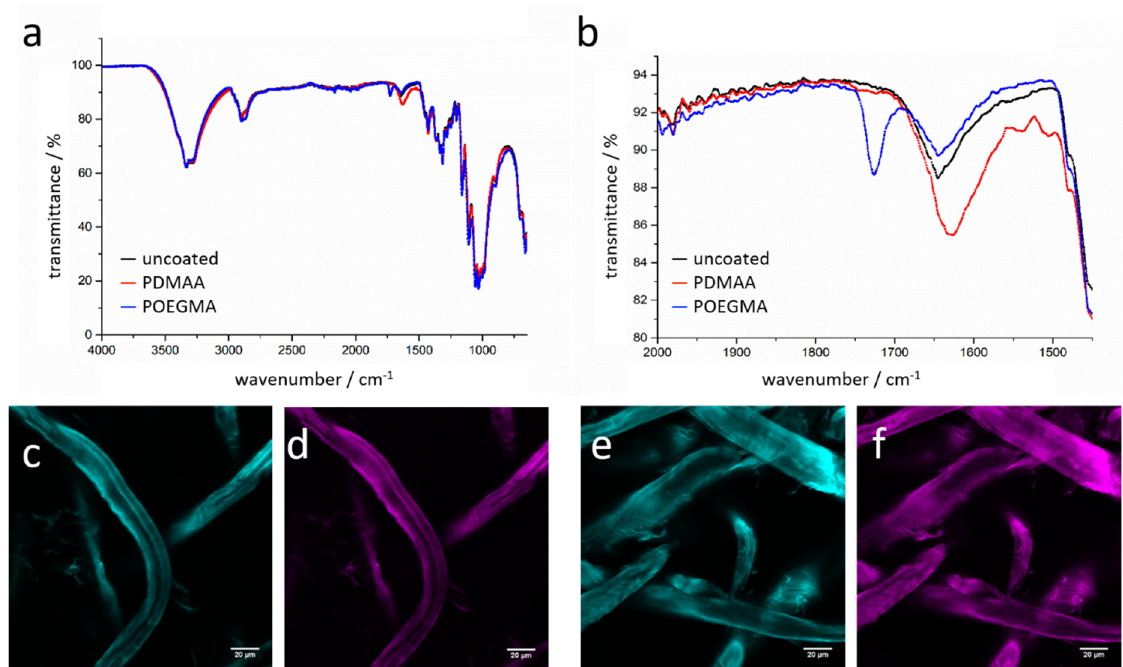
Figure 2. IR spectra of uncoated cotton linter paper (black) in comparison with PDMAA-coated paper (red) and POEGMA- coated paper (blue) are shown ( a ). In a close-up, the changing bands at 1600–1750 cm –1 are clearly visible ( b ). CLSM images show cotton linter fibers stained with calcofluor white ( c , e , cyan), as well as the distribution of PDMAA ( d ) and POEGMA ( f ) on the respective fibers (magenta).